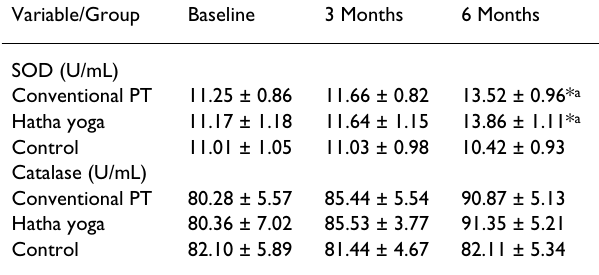
Values represent Mean ± S.E. *p < 0.05; a: significantly different from